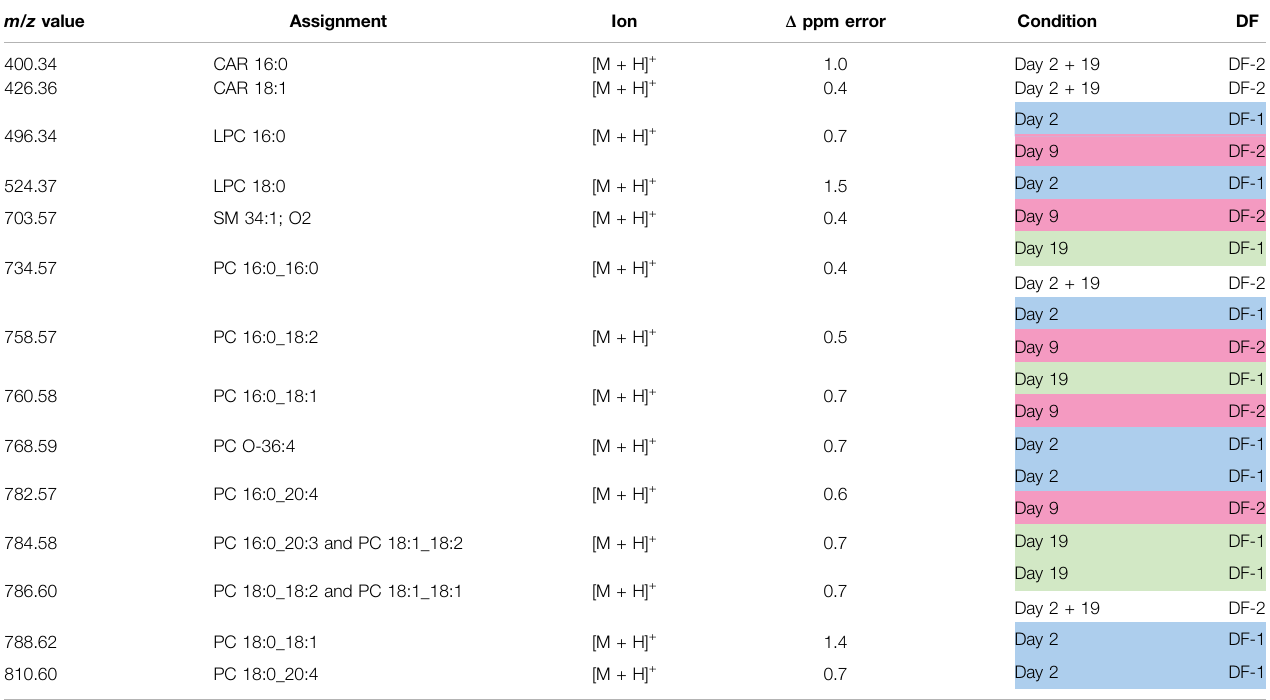
TABLE 4| LipidassignmentsbasedonMS/MSand highmassresolutionexperiments inpositiveionmode.Foreachassignment,the m/z valueobtainedwiththehighmass resolution mass spectrometer (Orbitrap Elite), the lipid assignment, the detected ion, the ppm error, the condition to which the m/z value contributes, the DF, and the corresponding scaled loading are